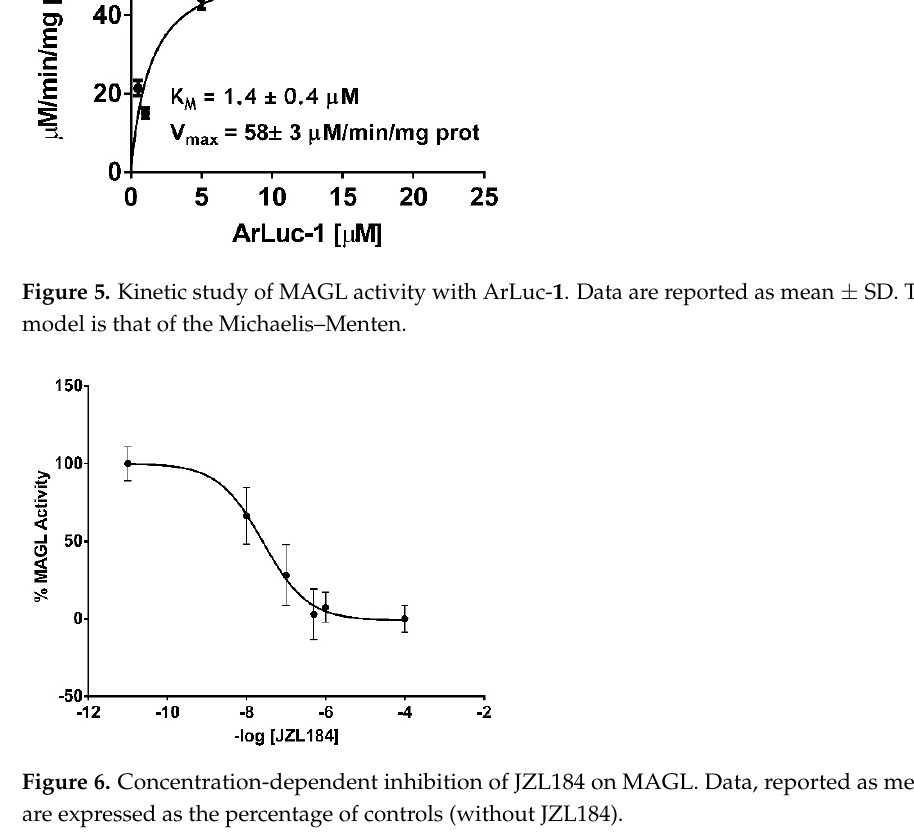
Figure 6. Concentration-dependent inhibition of JZL184 on MAGL. Data, reported as mean ± SD, are expressed as the percentage of controls (without JZL184).